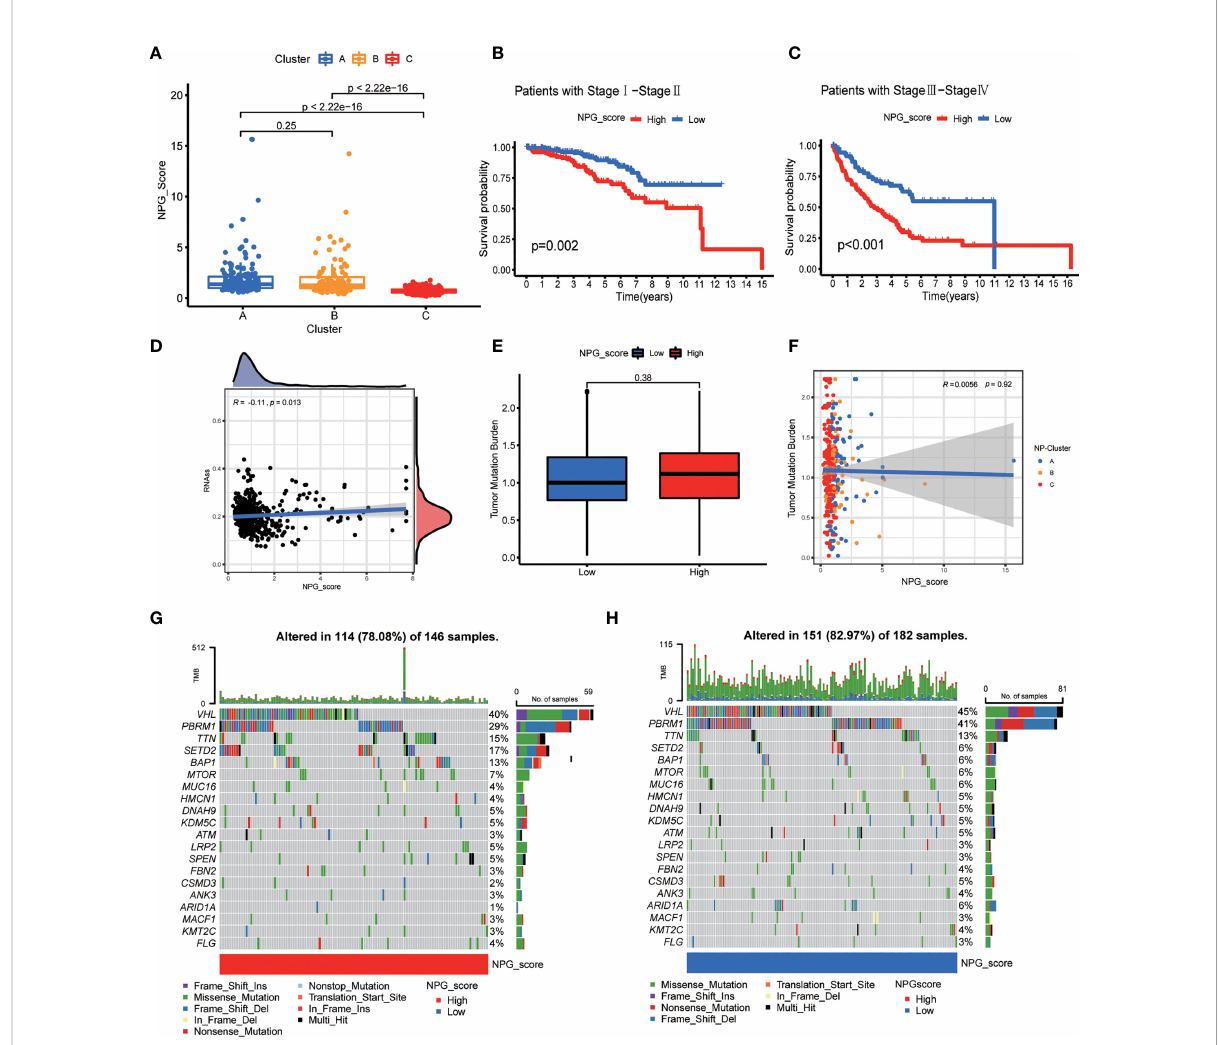
FIGURE 6 Correlation of NPG score with clinical features, CSC index, and TMB. (A) Comparison plot illustrating the differences of NPG score in three NP- Clusters. (B, C) Kaplan – Meier curves for comparison of NPG score risks between low-NPG score and high-NPG score groups by strati fi ed analysis of pathological stages. (D) Correlation of NPG score and CSC index. (E, F) Tumor mutation burden analysis. (G, H) Landscape of tumor mutation burden between high- and low- NPG score